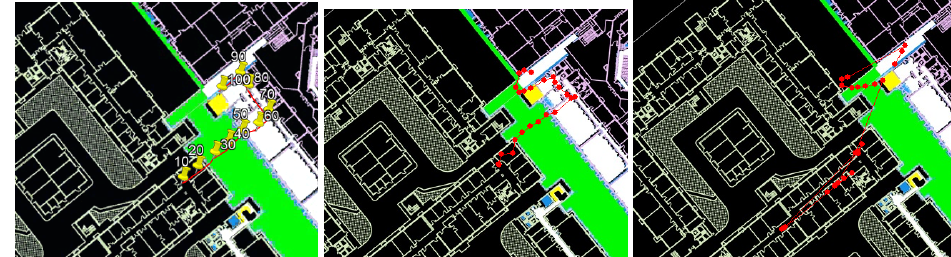
Figure 21. The negative effect of using geolocation service. ( Left ): ground truth. ( Center ): STEPS report without geolocation service resample. ( Right ): STEPS report with geolocation service resample. In this example, a significant positioning error in the geolocation service caused a major drift in the system because the true position was often outside of the particle filter ROI